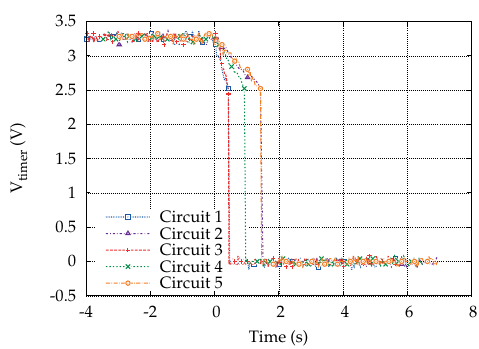
Figure 8. Measurement results of the different current sources. The capacitor voltage is drawn as a function of